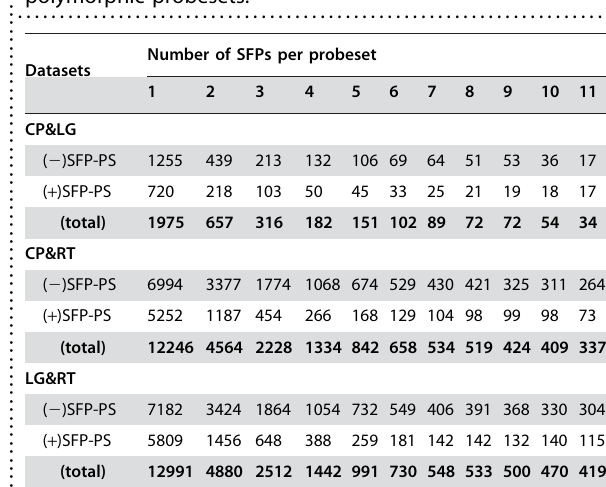
Table 2. Distribution of gene-chip predicted SFPs among